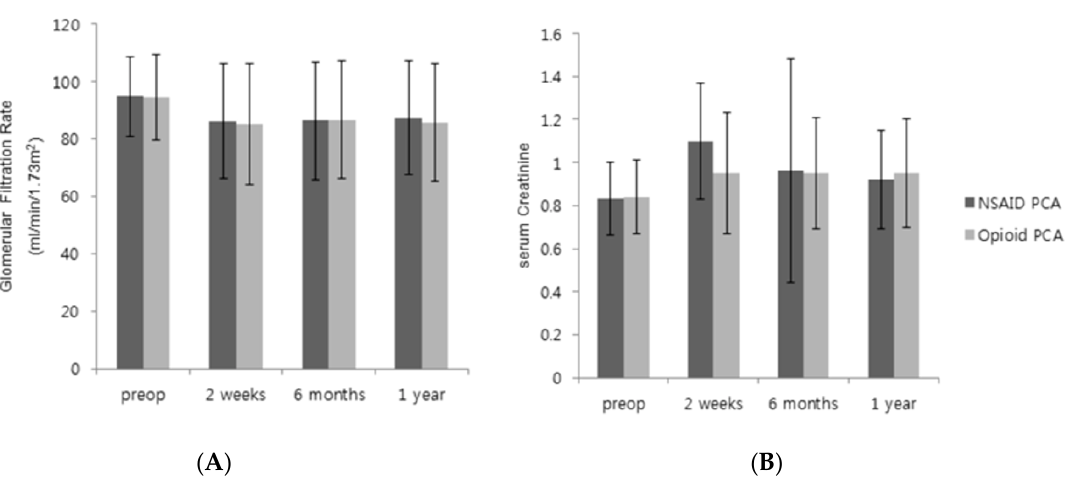
Figure 2. Pre- and postoperative glomerular filtration rate (GFR) and serum creatinine. ( A ) GFR, ( B ): serum creatinine. Comparison of GFR and serum creatinine between NSAID PCA group and opioid PCA group. There were no significant differences. Results are expressed as mean ± SD.